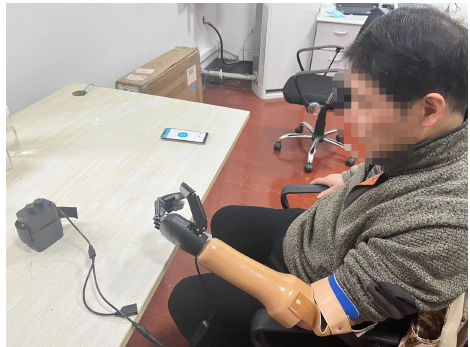
Figure 3. The setup of one rehabilitation training